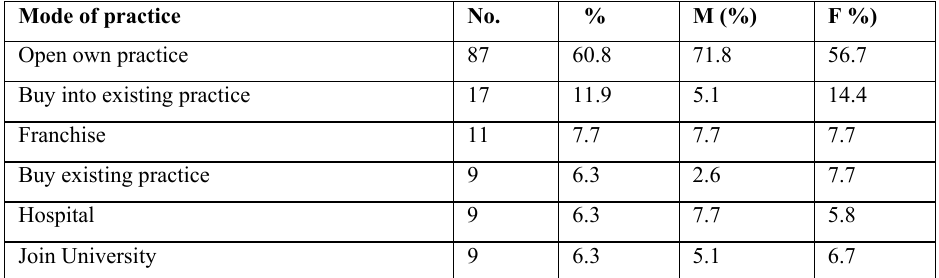
Table 6: Type of practice (which is likely to provide the greatest fulfilment for personal goals within the next decade), number, percentages and gender percentages